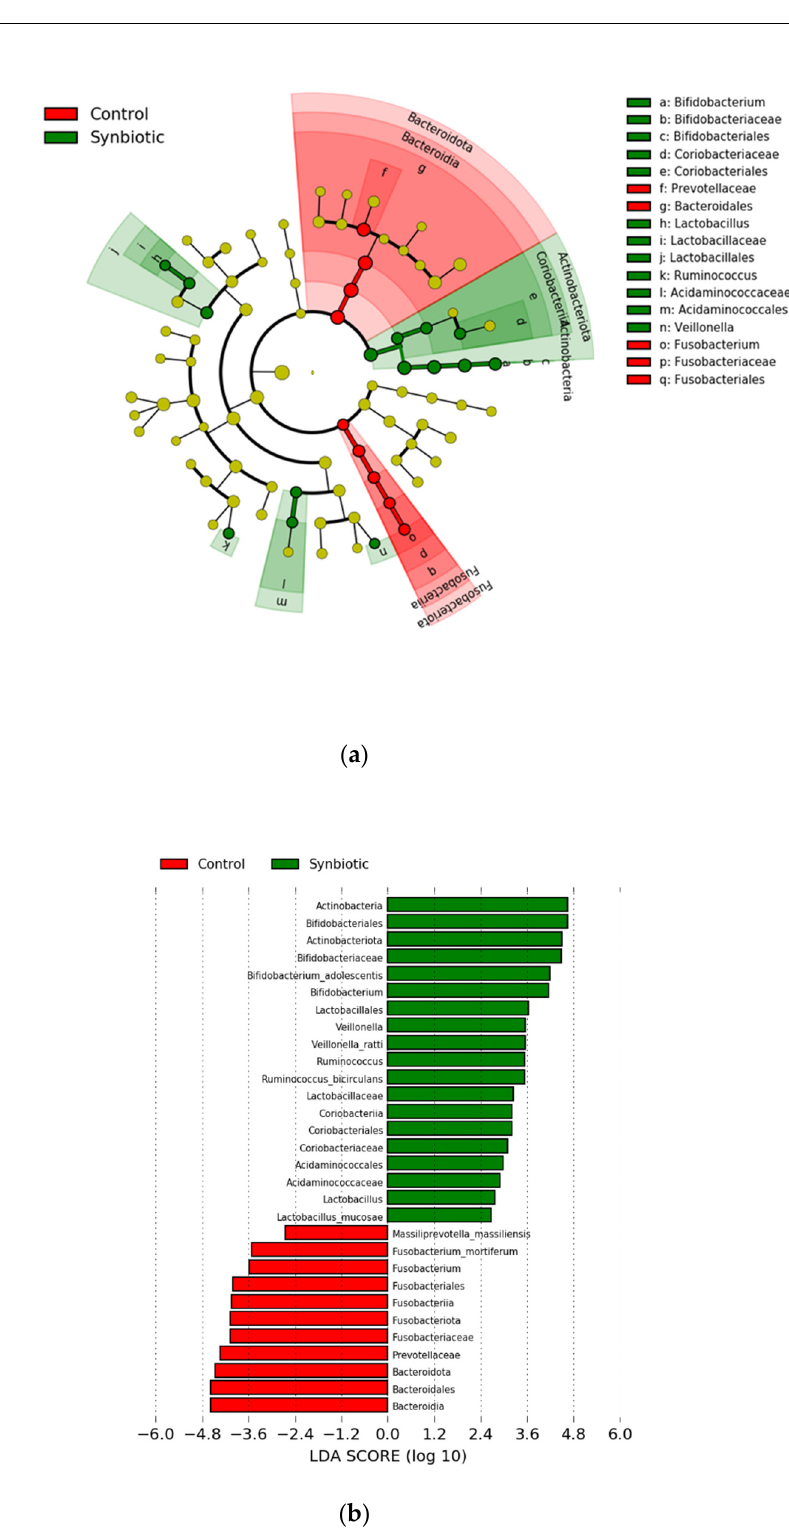
Figure 2. Linear discriminant analysis (LDA) effect size (LEfSe) effect size was used to calculate the taxa that best discriminated between the synbiotic and control groups. ( a ) Expressed in a cladogram, taxa that reached a linear discriminant analysis score (log10) >2.0 are highlighted and labelled accordingly. ( b ) LDA score >2.0 at taxonomic levels from phylum to species.